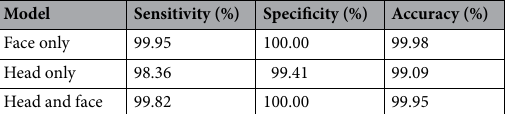
Table 2. Classification results for the binary classification